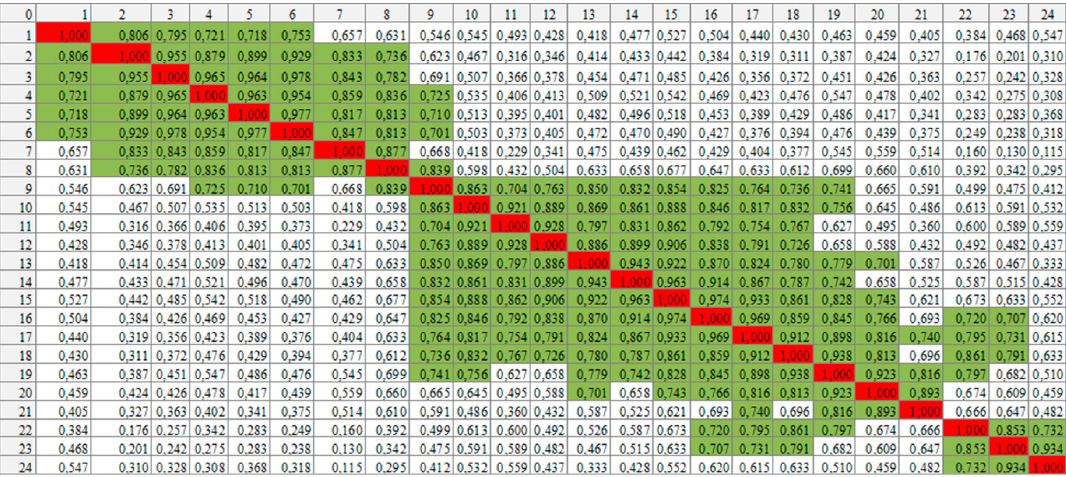
Figure 16. Correlation matrix for determining relevant historical range of similar hours on example for hourly price forecast for 15 November 2017.